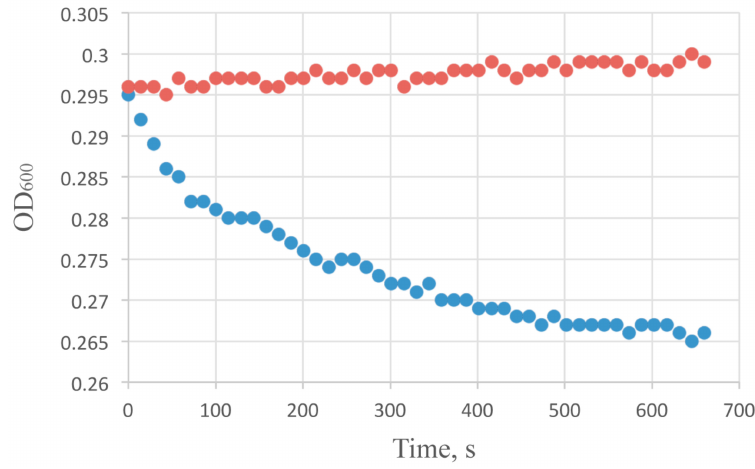
Figure 1. Bactericidal activity of AcLys (100 µ g/mL) on viable E. coli CR63 cells in LB media normalized to pH 6.0 with Bis-Tris buffer at 25 ◦ C (blue). Background E. coli CR63 optical density at the same conditions with no enzyme added is shown in